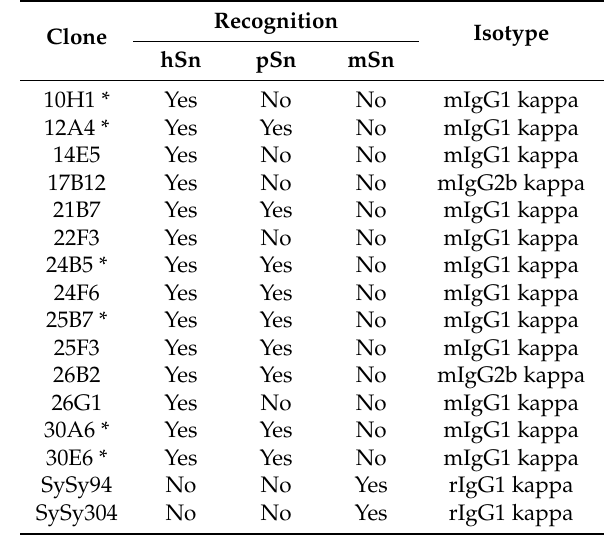
Table 1. Overview of developed hybridoma clones. A selection was made by screening the hybridomas with enzyme-linked immunosorbent assay (ELISA) for recognition of human sialoadhesin-positive (hSn + ), porcine sialoadhesin-positive (pSn + ), and murine sialoadhesin-positive (mSn + ) cells. * Indicated clones were selected for further experiments after screening with ELISA, fluorescent microscopy and flow